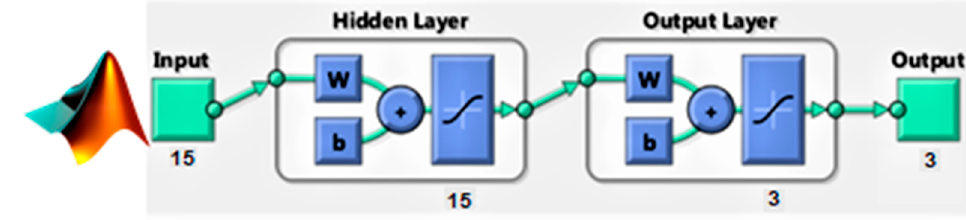
Figure 7. The structure of the model of the MLP 15:15-15-3:3 neural network type generated by the Neural Network Toolbox (MATLAB).